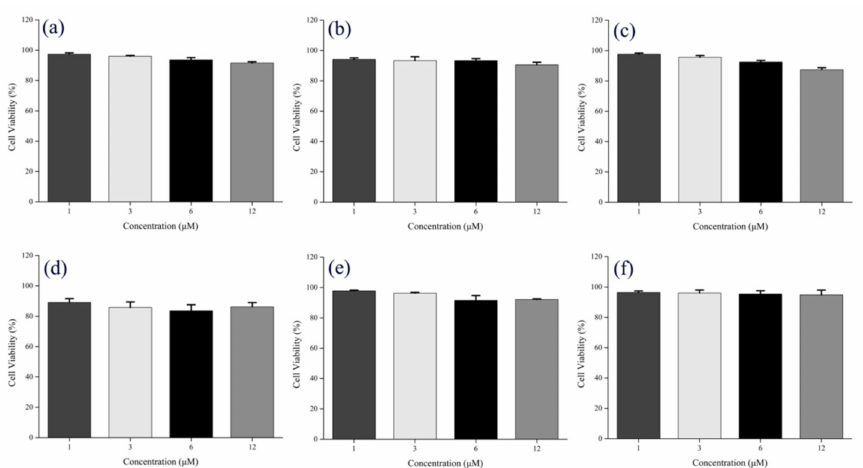
Figure 7. Cell viabilities of A549 cells co-cultured with different concentrations of compounds ( a ) 1 , ( b ) 2 , ( c ) 3 , ( d ) 4 , ( e ) 5 , ( f ) 6 for 24 h.